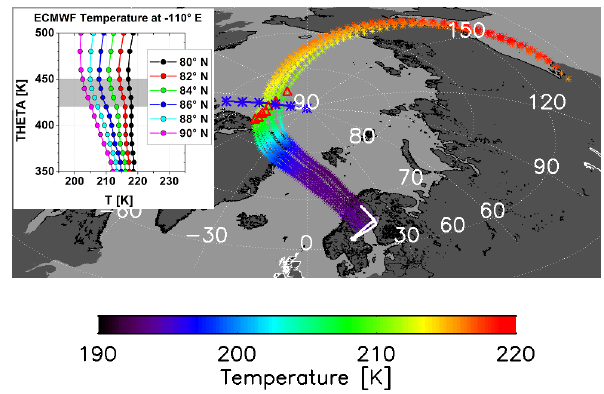
Figure 2. CLaMS particle backward trajectories coloured according to temperature (asterisks) for simulated NAT particles with diame- ters between 5 and 11µm associated with the Geophysica flight on 25 January 2010. Prior to the nucleation events the particle trajecto- ries are continued by air mass trajectories for the air volumes where nucleation occurred. The flight track of the Geophysica is indicated by a solid white line. Positions where the trajectories reach 210K are marked by red triangles. Blue asterisks connected by a blue line indicate the positions of the temperature profiles shown in the inset. The grey shading in the inset indicates the potential temperature (THETA) levels corresponding to the vertical range of about 18km to 20km in the model domain (from Woiwode PhD thesis, 2013, with